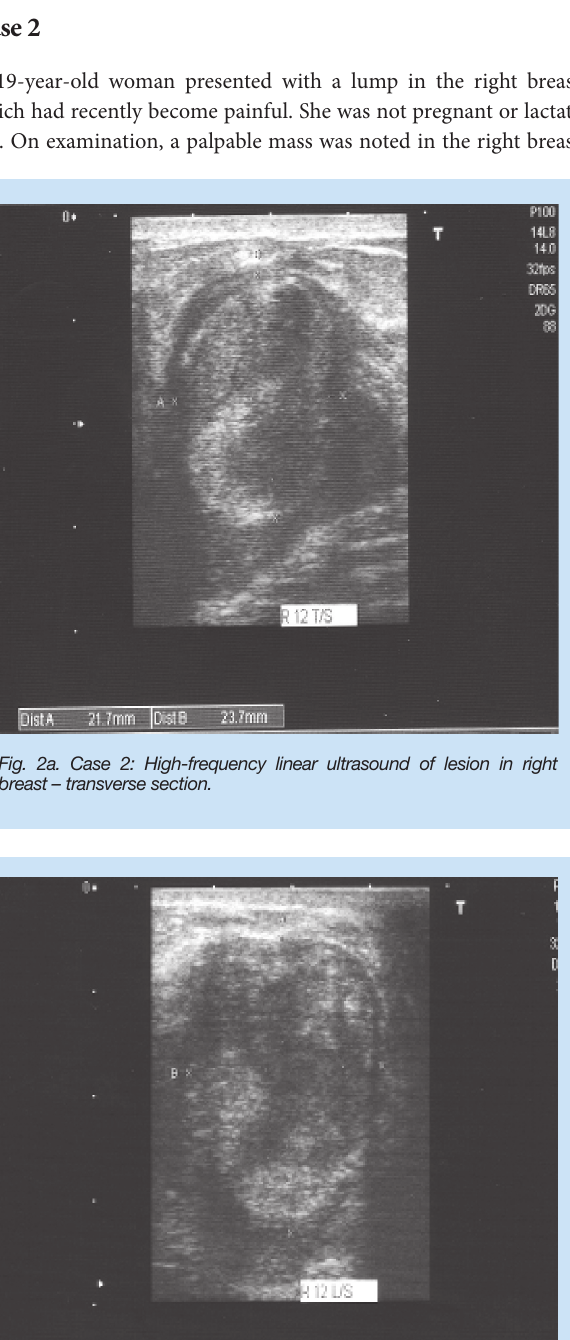
Unusual presentation.indd